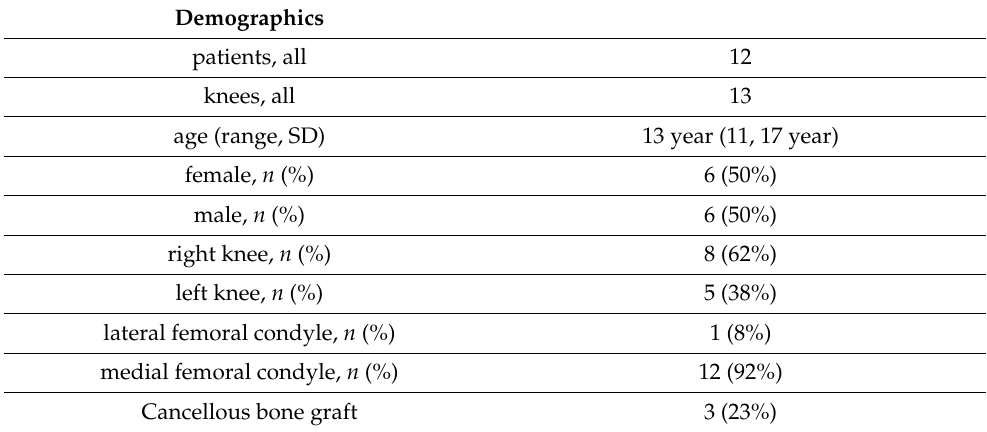
Table 3. Demographics of all included